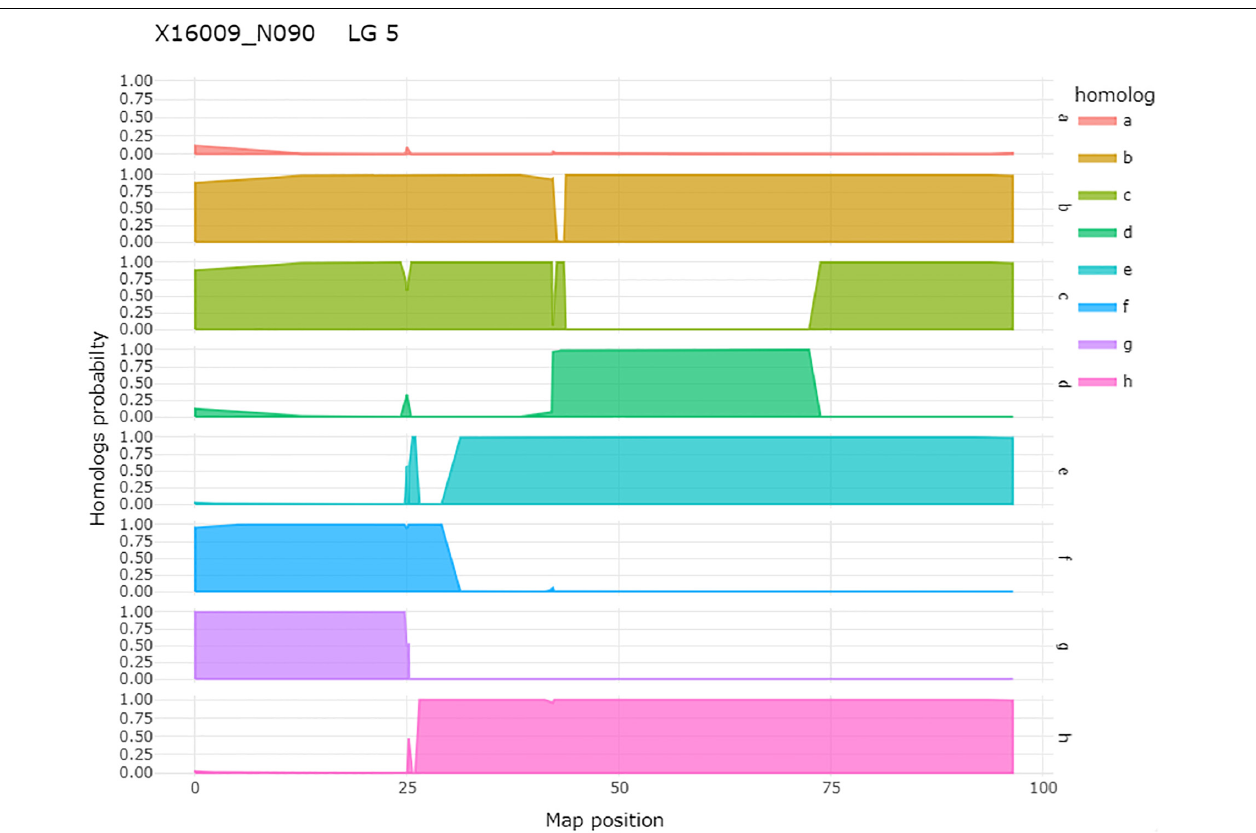
FIGURE 5 | An example of homolog probabilities for each parental homolog for one individual, 16009-N090, of a tetraploid biparental mapping population on LG 5. On the y -axis is the probability that the individual carries the parental homolog. On the x -axis is the map position in centimorgan. In the case of this individual, the h-homolog at 35.08 cM carries the resistant allele for qRRD.SWxBE-ch5, and this is an individual that carries the resistant